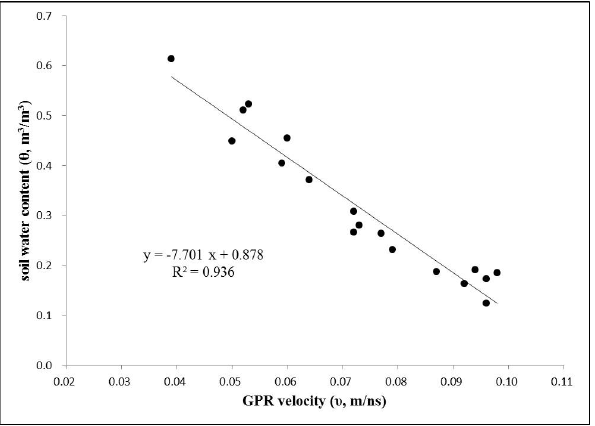
Figure 10. Scatter diagram of the relationship between GPR velocity and active-layer soil moisture.